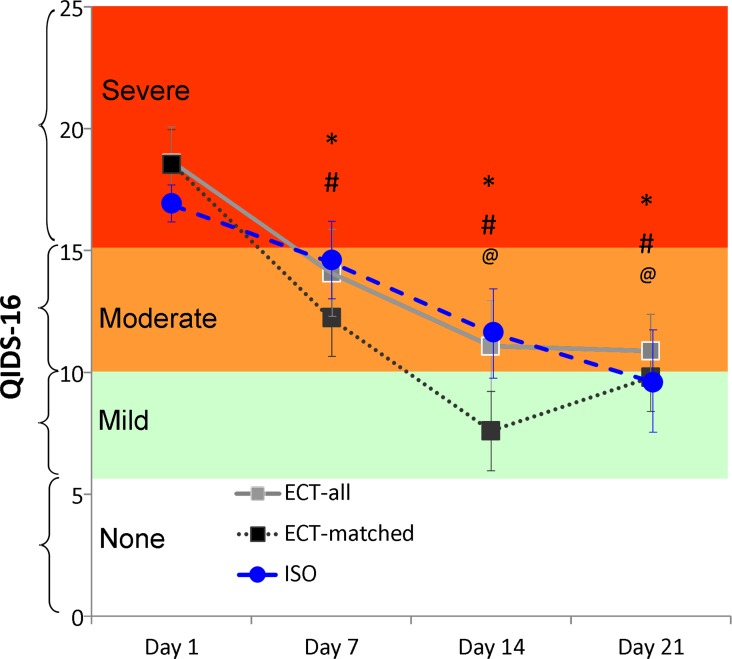
Scores on the Quick Inventory of Depression Scale (QIDS-SR16) self report form over 21 days of treatment (treatment sessions 1–10).For brevity, results are depicted showing change over each week, from Day 1 (prior to 1st treatment), Day 7 (prior to 4th treatment), Day 14 (prior to 7th treatment), and Day 21 (prior to 10th treatment). *Within-group ECT-All Change from Day 1 p<0.05, # Within-group ECT-Matched Change from Day 1 p<0.05, @ Within-group ISO Change from Day 1 p<0.05.